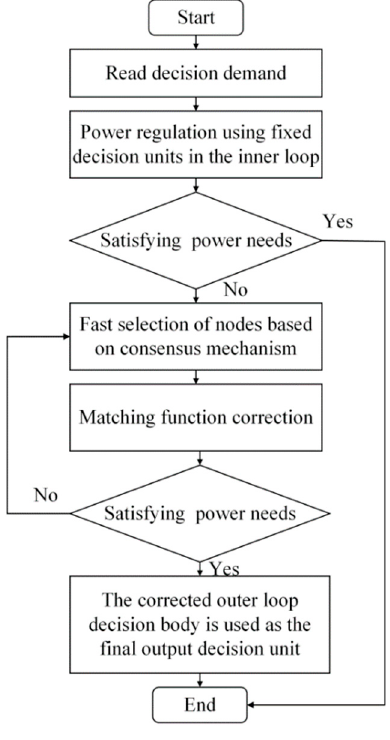
Figure 3. Decision flow chart.